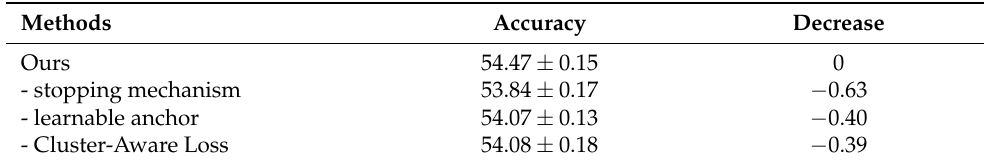
Table 6. Results of detailed analysis on cluster-aware loss module on OGB-MAG. We use the mean node representation as class centers in the “learnable anchor”